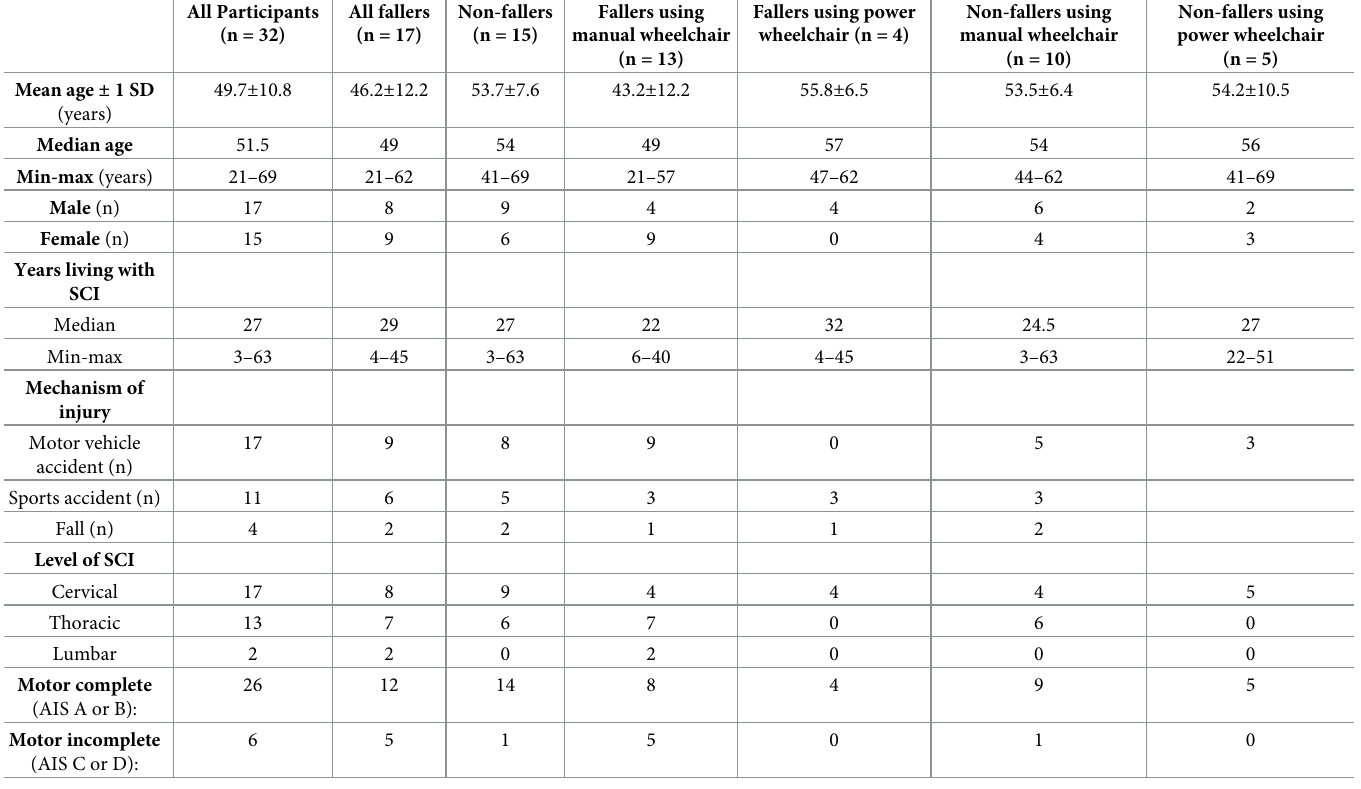
Table 1. Demographic characteristics and impairment characteristics of participants followed in phase